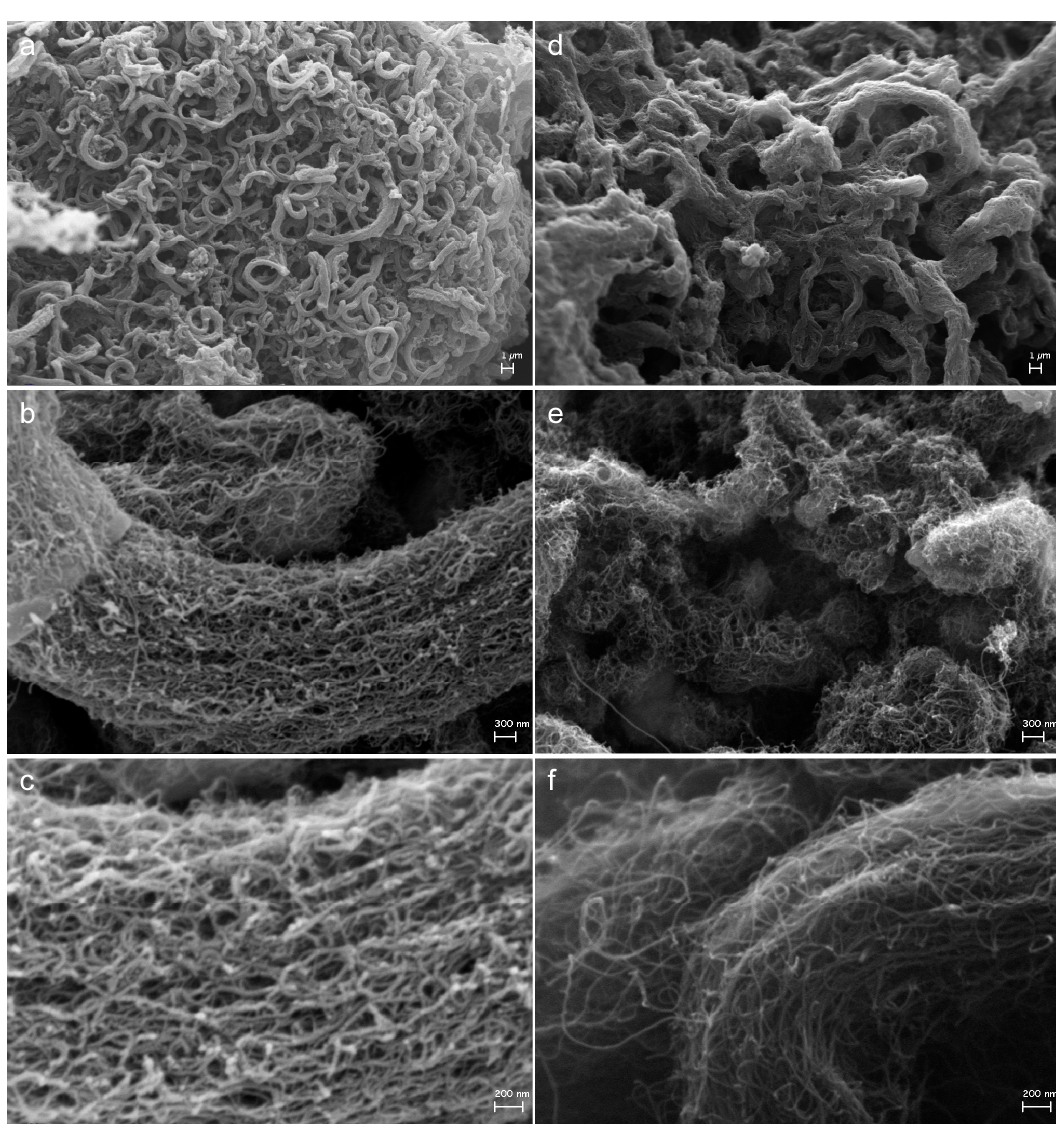
Figure 5. SEM micrographs of MW ‐ CNTs after functionalization with branched ( I ‐ BP50 ) and linear ( II ‐ LP50 ) PFPE peroxides: 2.5 ( a , d ), 50 ( b , e ) and 100 kx ( c , f ).